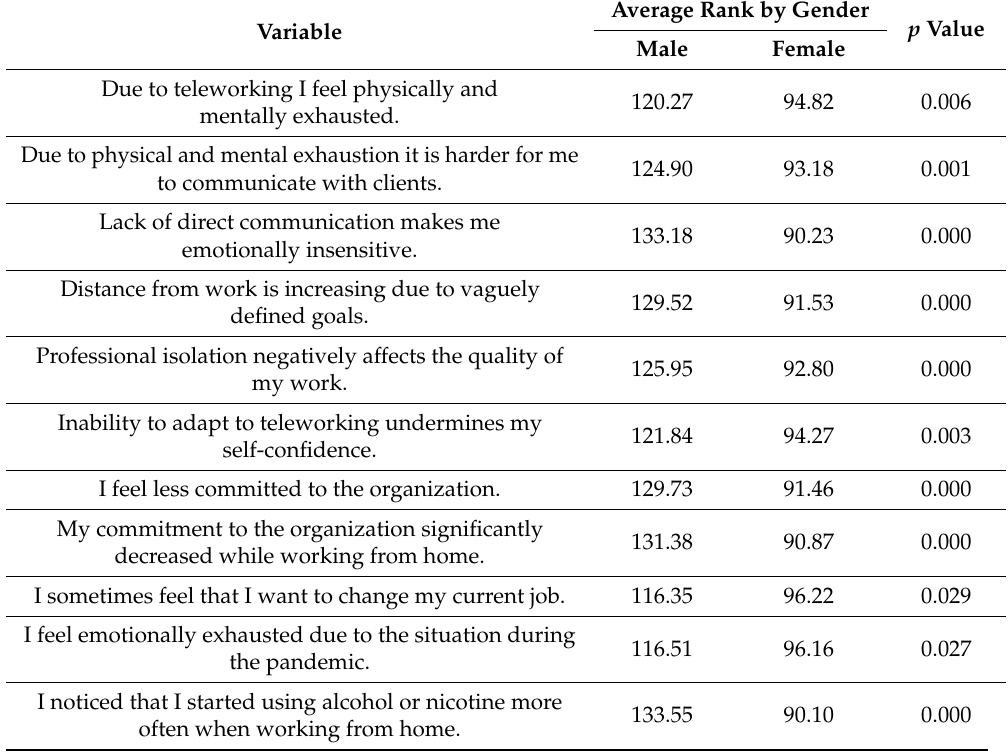
Table 14. Professional burnout by